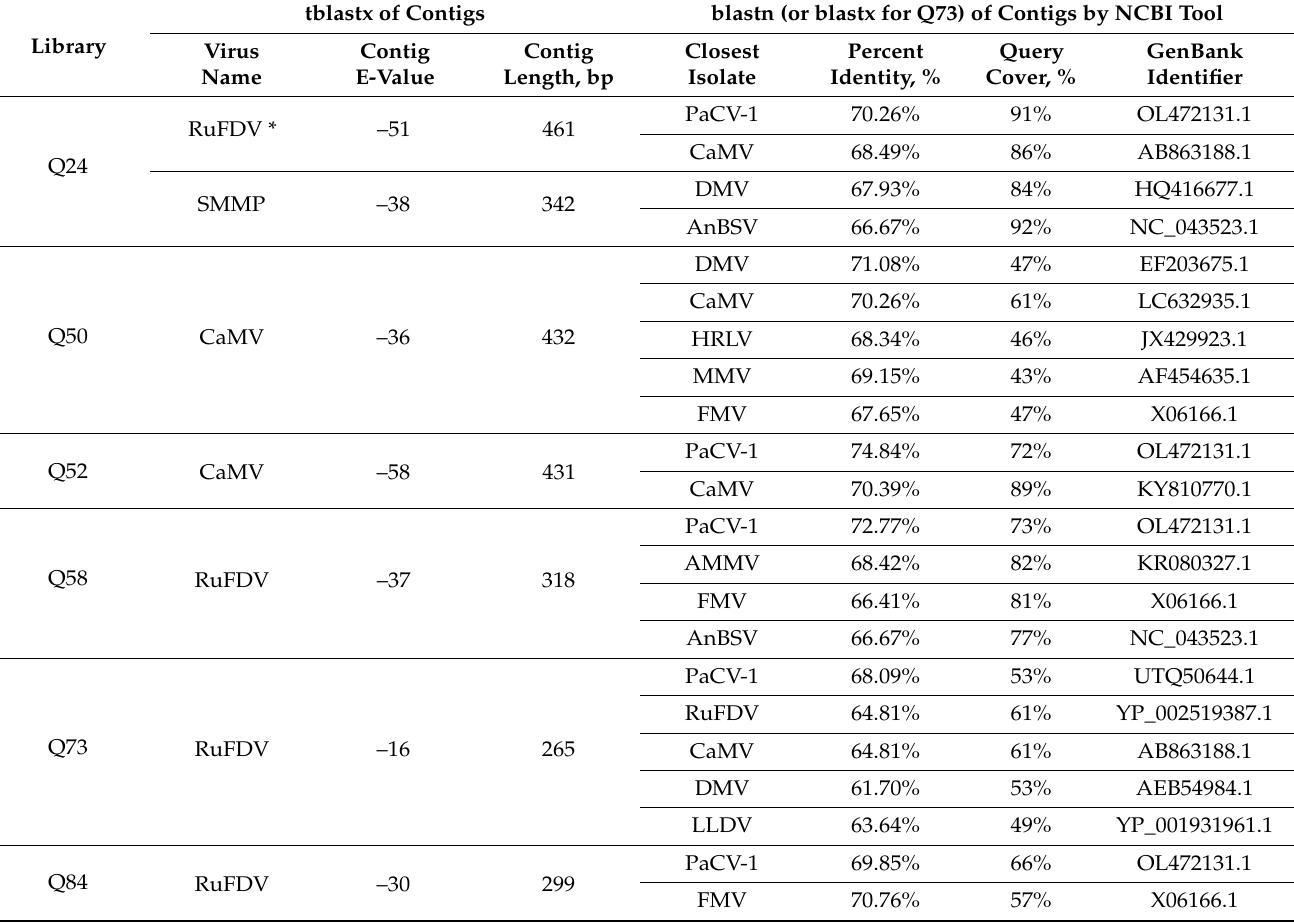
Table 1. Analysis of contigs of a putative new species of dsDNA grapevine-associated virus.